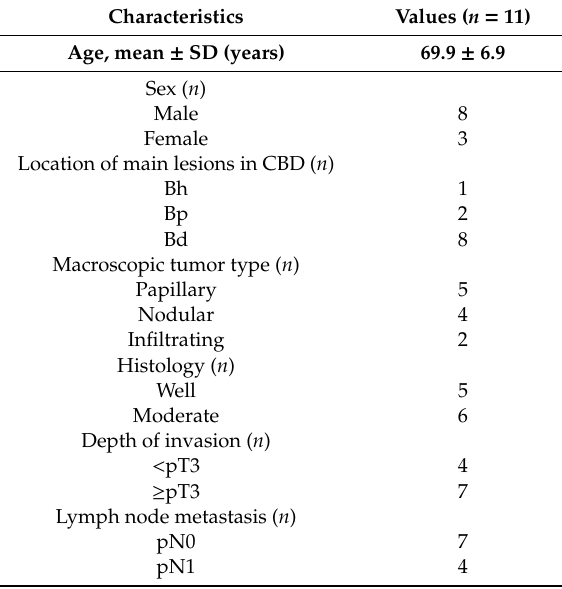
Table 1. Baseline characteristics of patients.